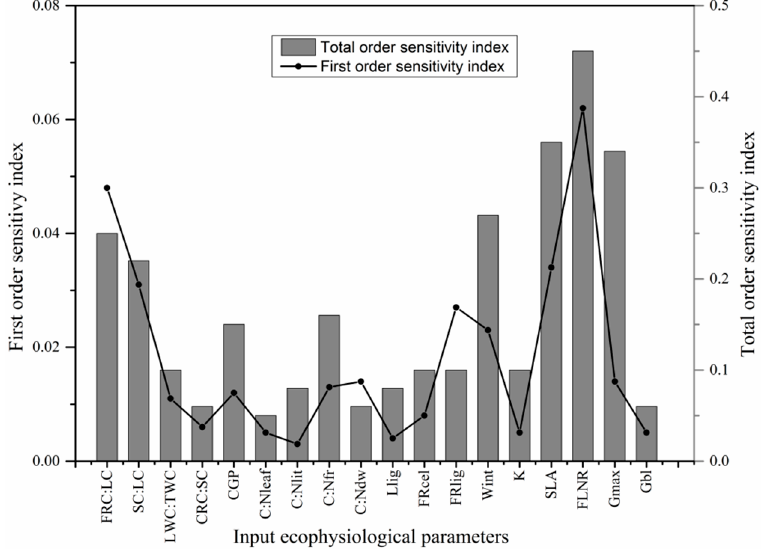
Figure 3. The first order and total order sensitivity indexes for annual mean GPP.